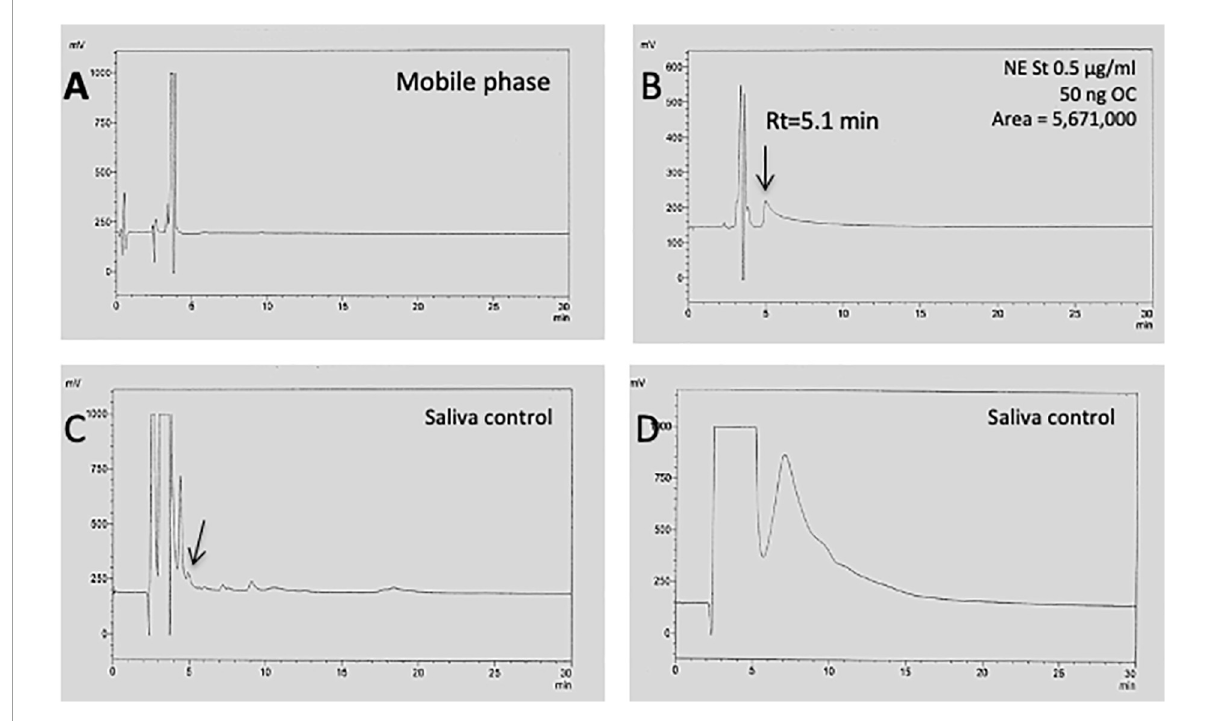
FIGURE2 HPLC chromatogram of saliva to detect norepinephrine. When only the mobile phase was injected onto the HPLC, an injection peak was seen but only a very low background (A) . Injection of a norepinephrine (NE) standard (0.5 µ g/ml) shows that NE elutes at approx. 5 min, giving a single peak (B) . Injection of pure saliva (1 mg/ml) shows a chromatogram with only a few peaks (C) , but also a very heterogeneous chromatogram, with a high peak load during the first 5 min, where NE could not be detected (D)